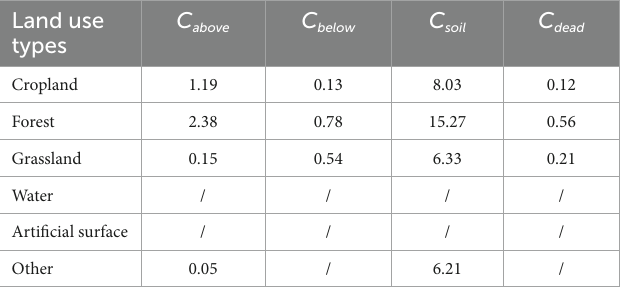
TABLE 2 Carbon density for each LULC (kg/m 2